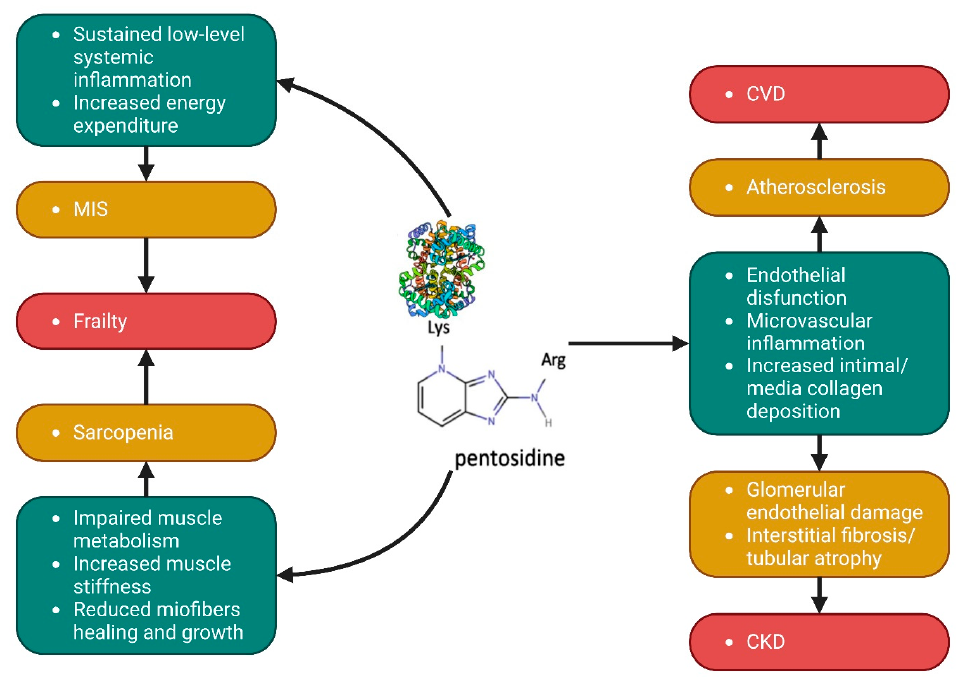
Figure 3. The influence of AGEs on nutrition, as well as muscle, cardiovascular, and kidney health. Note: MIS: malnutrition–inflammation syndrome; CVD: cardiovascular disease; CKD: chronic kidney disease. Modified protein surface models are based on the structure of human hemoglobin (PDB ID 1COH).